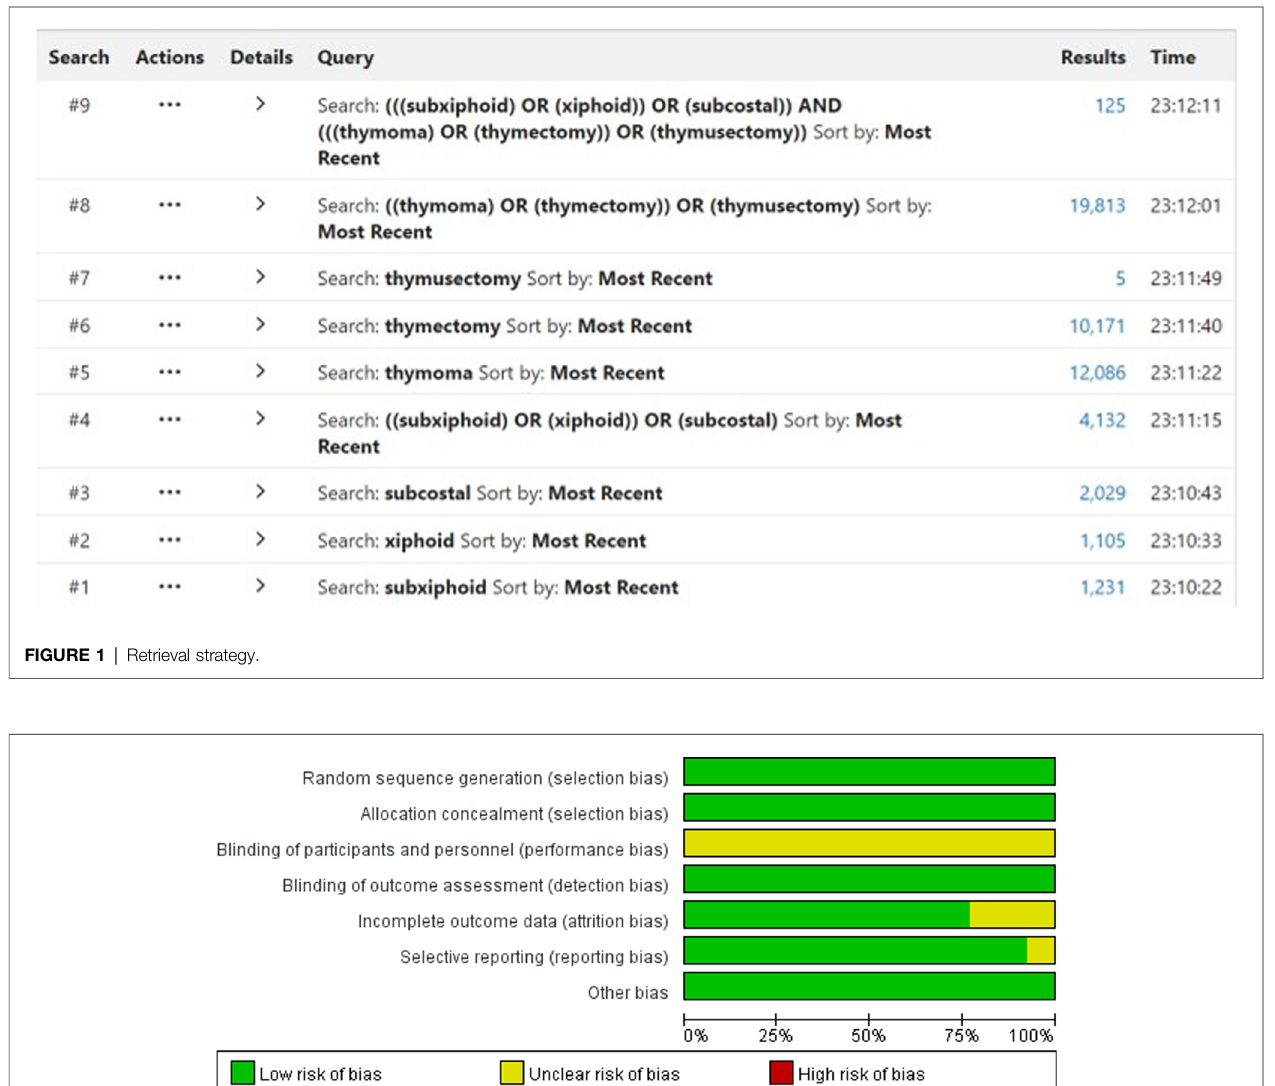
Figure 5 . The amount of intraoperative blood loss in the